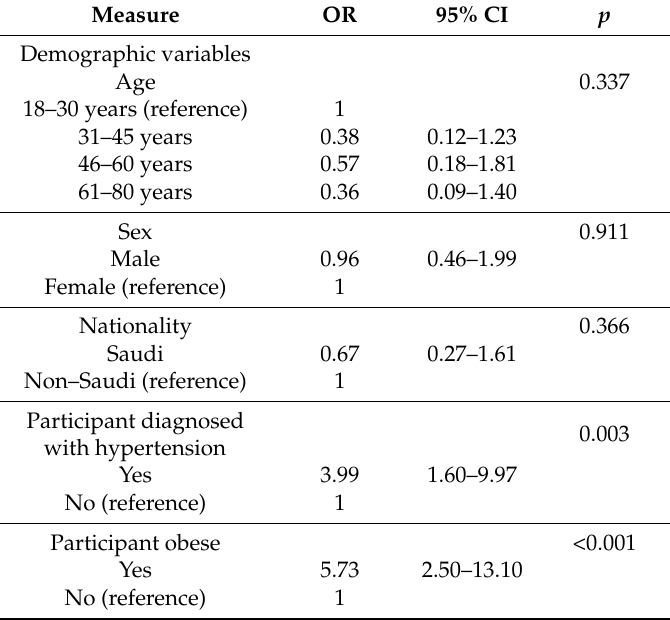
Table 4. Odds ratios and 95% confidence intervals for predictors of high risk for sleep apnea using the combined Berlin Questionnaire and Epworth Sleepiness Scale